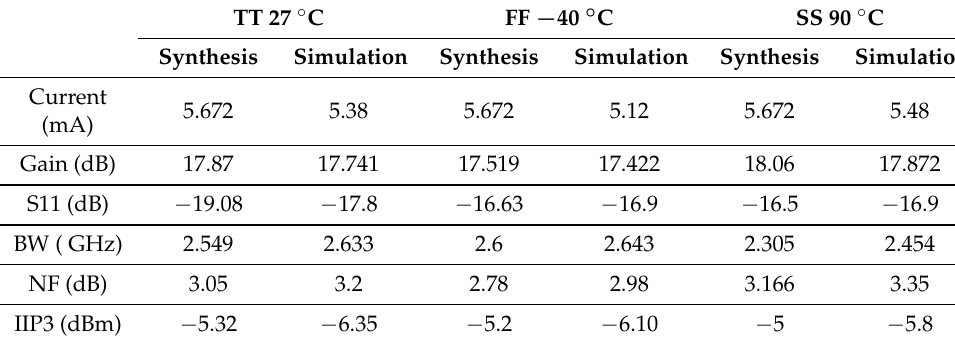
Table 5. Comparison of the achieved specifications from the proposed synthesis flow vs. spectre simulation results for the first design